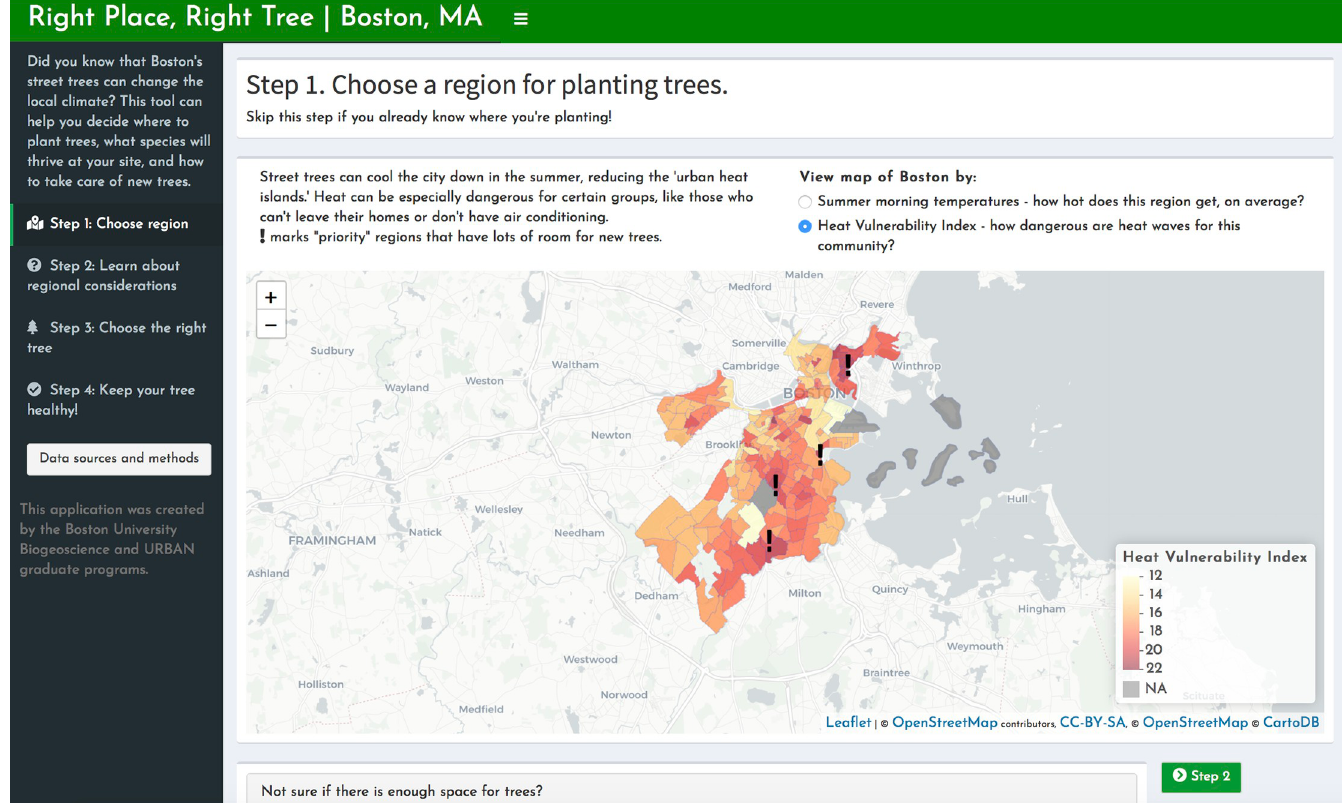
Fig 1. “Step 1: Choose a region for planting trees”. The first page of the interactive decision-support tool recommends identifying a region (census tract) within Boston for planting trees. This page displays maps of mid-morning land surface temperature (LST) as well as Heat Vulnerability Index (HVI), and clicking on the map displays the neighborhood name. Below these maps, an expandable section addresses the potential for canopy expansion for each census tract, and provides a list of resources for alternatives to tree-planting that may also counter urban heat. Map tiles were republished under a CC BY license, with permission from CARTO,